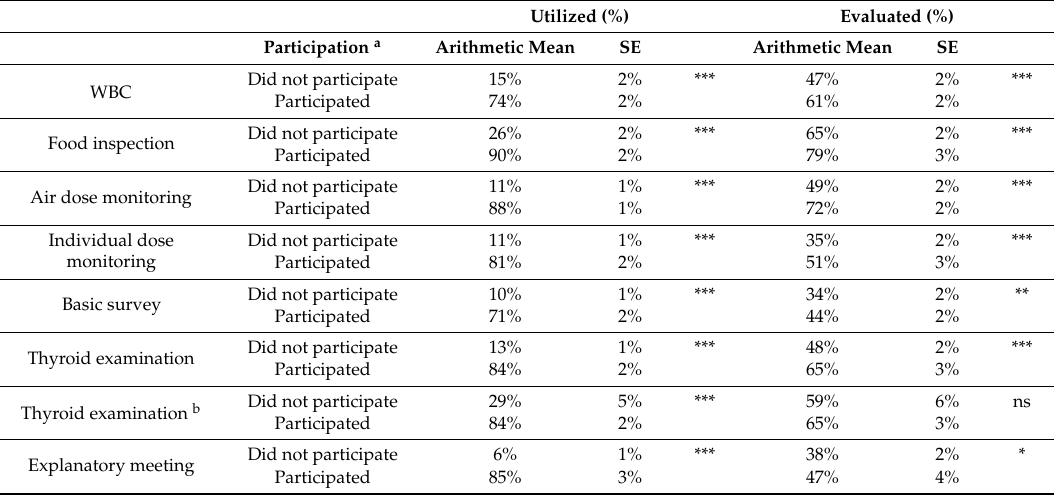
Table 3. Differences in proportions of utilization or evaluation for each radiological countermeasure between the participation and non-participation.